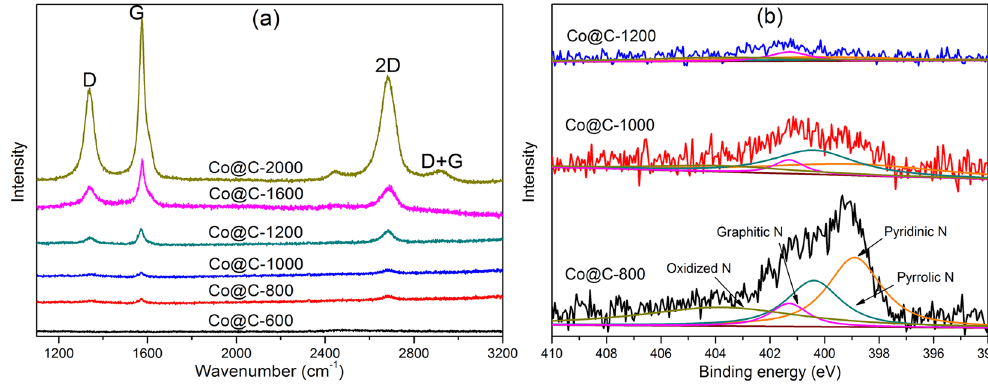
Figure 4. ( a ) Raman spectra, and ( b ) high-resolution N 1 s XPS spectra of the as-synthesized Co@C